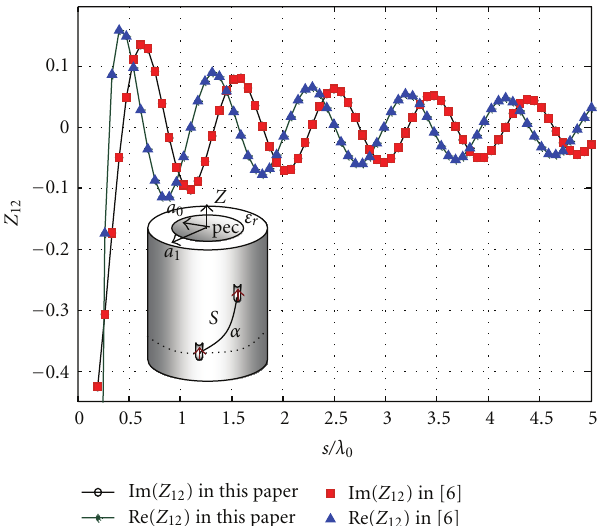
Figure 6: Real and imaginary parts of the mutual impedance ( Z 12 ) between two identical z - directed current sources versus separation S when α = 700 ◦ (unaxial line